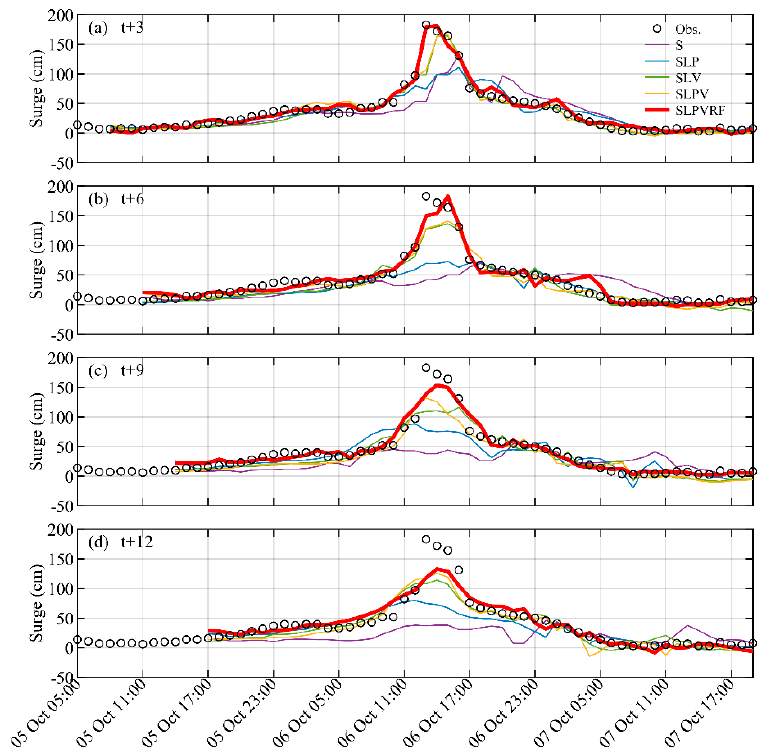
Figure 7. Long-lead-time storm surge predictions obtained by different combinations of controlling parameters for Krosa event (training): ( a ) t + 3; ( b ) t + 6; ( c ) t + 9; ( d ) t + 12.